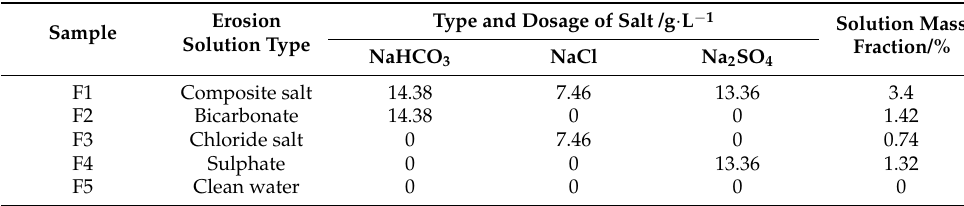
Table 3. Composition and mass fraction of erosion solution.